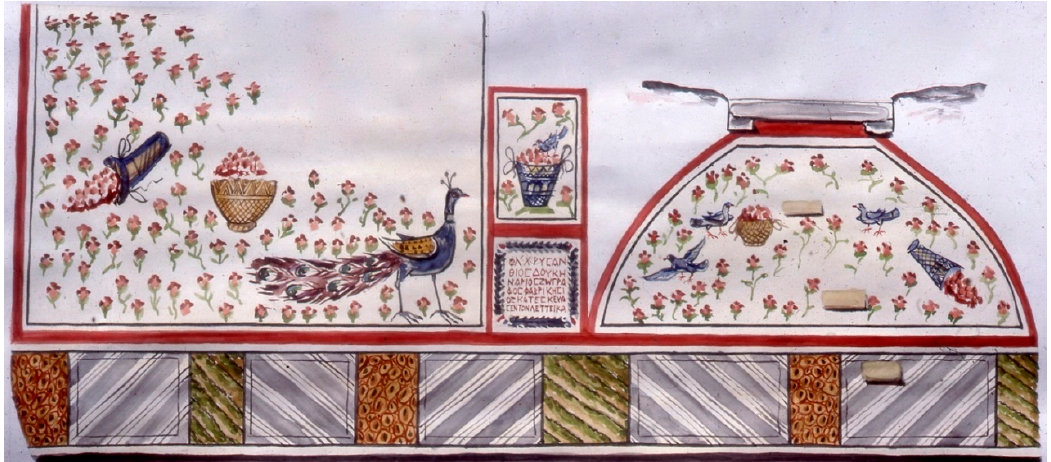
Figure 4. Sardis, Tomb of Chrysanthios (Tomb 76.1, Appendix A.1), painting of west and north walls. © Archaeological Exploration of Sardis/President and fellows of Harvard College.